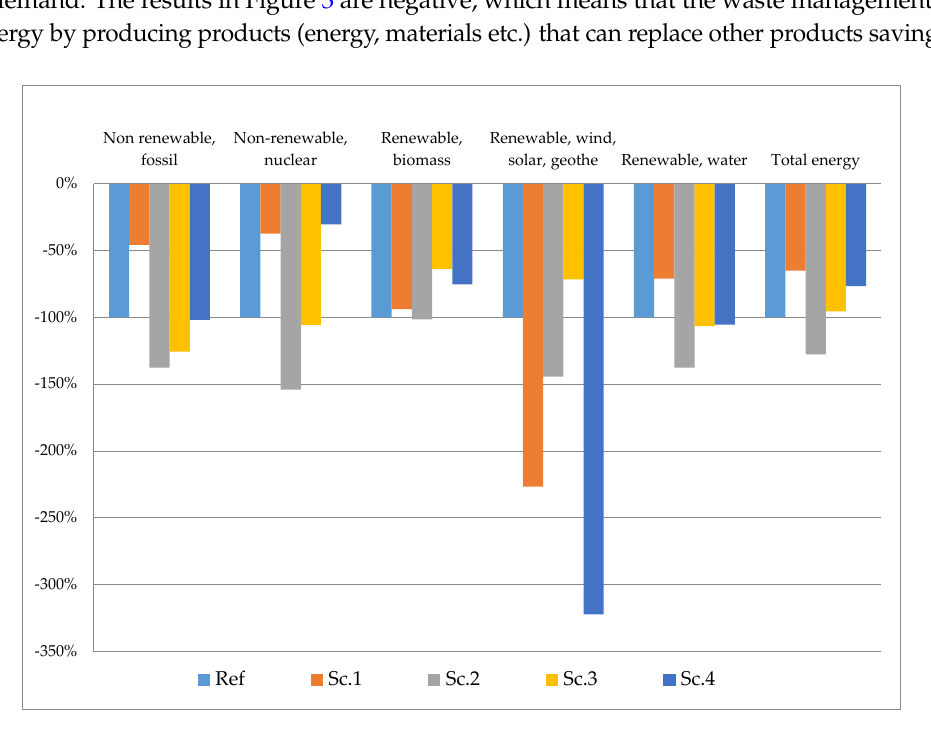
Figure 3. Relative cumulative energy demand of the waste treatment system (including avoided burdens) for the four base scenarios compared to the reference scenario set to